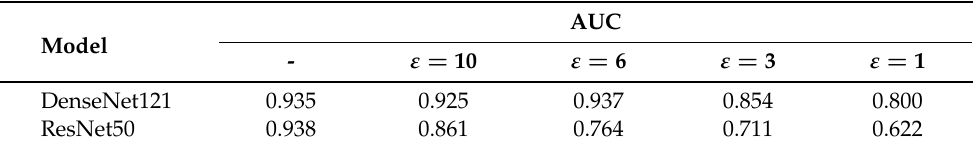
Table 7. Mean AUC of global DenseNet121 and ResNet50 models, evaluated on the clients’ test sets for non-private training and private training with varying ε values. Stronger privacy guarantees decreased model performance.